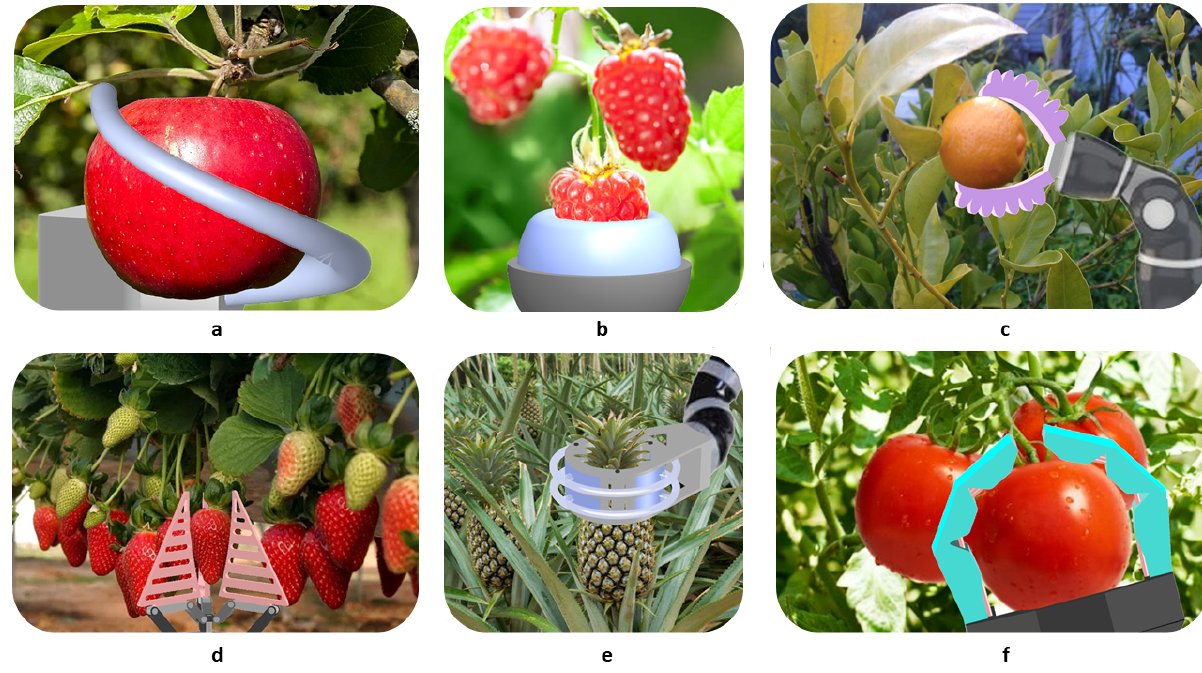
Figure 6. Hypothetical harvest scenarios with several soft grippers. ( a ) Soft continuum gripper based on [256], ( b ) end- effector based on [257], ( c ) bellow-type soft gripper based on [224], ( d ) multi-choice gripper based on [258], ( e ) circular soft gripper based on [220,230], and ( f ) tendon-driven soft gripper based on